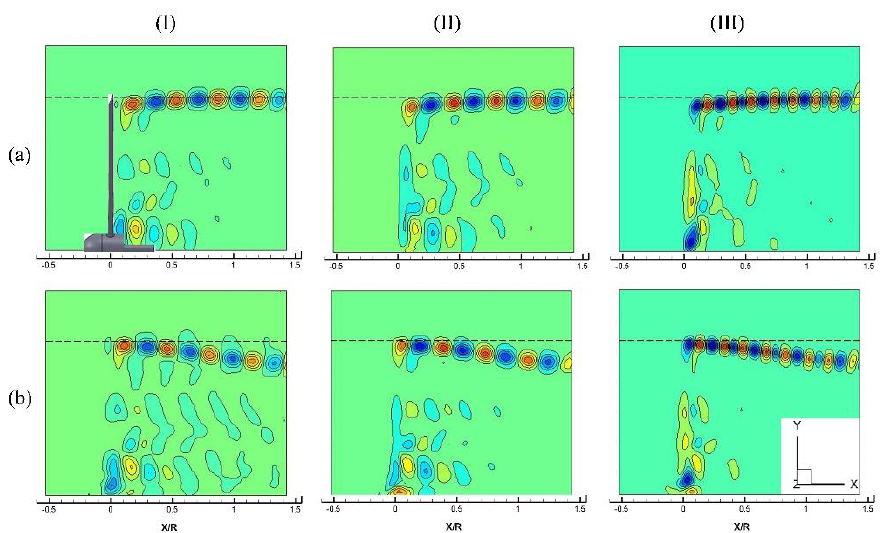
Figure 5. Proper orthogonal decomposition (POD) analysis for time-averaged data: Vorticity contours showing ( I ) first mode (22% of total energy), ( II ) second mode, and ( III ) third POD modes for different tip clearance ratios ( 𝛿ℎ 𝑈 = 0.55, row a, and 𝛿ℎ 𝑈 = 0.27, row b).